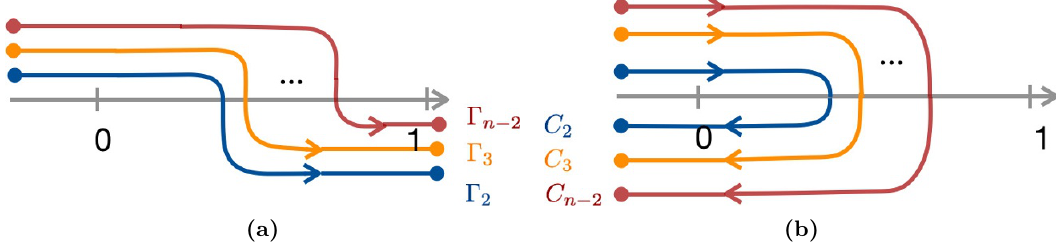
Figure 1. Integration contours associated with world-sheet variables v (cid:0)